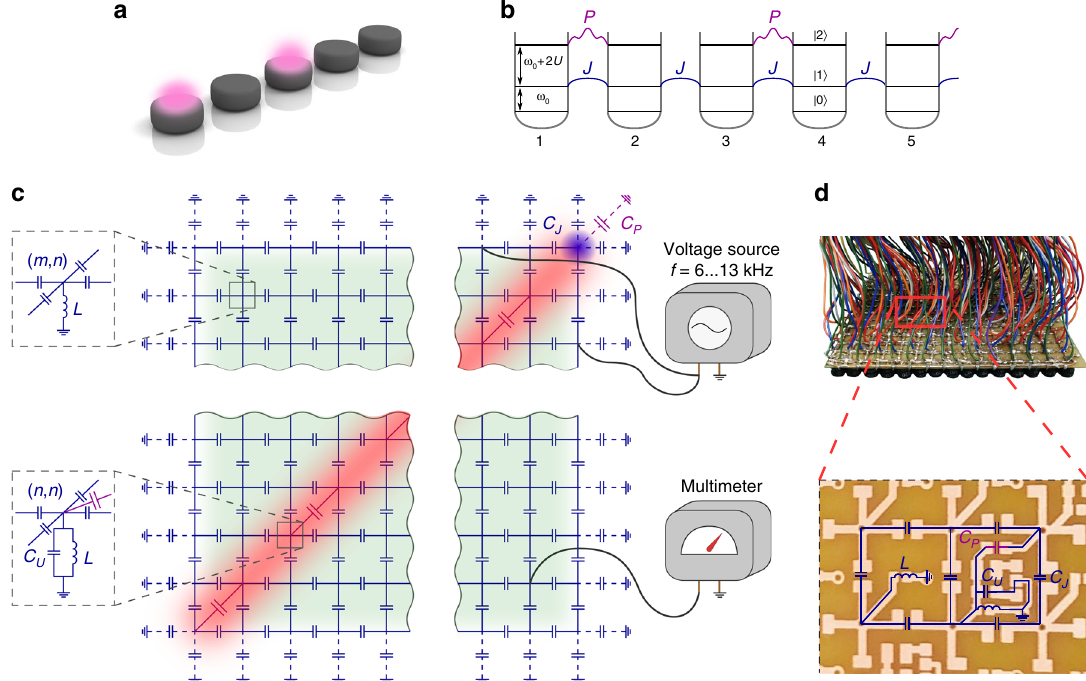
Fig. 1 Two-photon one-dimensional quantum problem and its topolectrical circuit simulator. a Artistic view of two-photon excitations in the array of ^ a y microresonators with tunneling couplings. The depicted state is ^ a y 0 j i . b Extended version of Bose – Hubbard model considered in the present article. 1 3 Single-photon tunnelings J are shown by blue solid lines, direct two-photon tunnelings P are indicated by purple wavy lines. c Top view of the equivalent two-dimensional topolectrical circuit with a voltage at the site ( m , n ) corresponding to probability amplitude β mn for one photon to be located at the m th resonator of the array with another one located at the n th resonator [cf. Eq. (2)]. Colored regions show characteristic voltage patterns for two-photon scattering states (green), doublons (red), and doublon edge state (blue). External voltage source applied for the system excitation and voltmeter are shown to the right. Side view of the diagonal (lower inset) and off-diagonal (upper inset) sites of the topolectrical circuit, where grounding elements are shown. d The photograph of experimental setup having the size of 15 × 15 nodes. Inset shows the enlarged fragment of the circuit which includes two unit